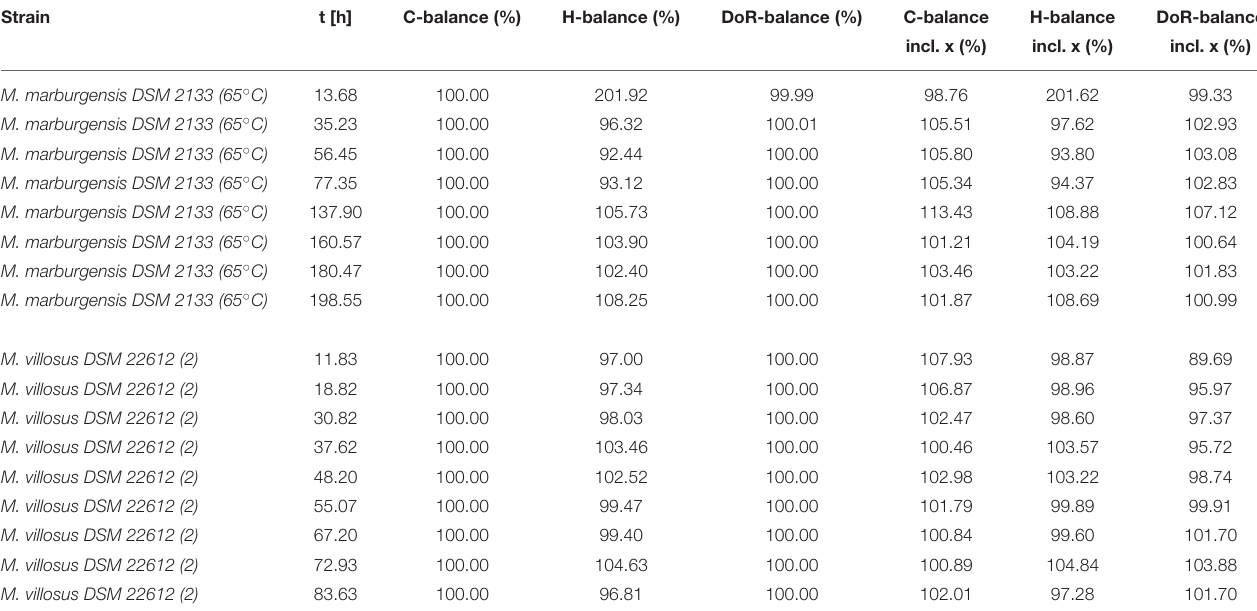
TABLE 3 | Mass balances of the two experiments with OD measurements.